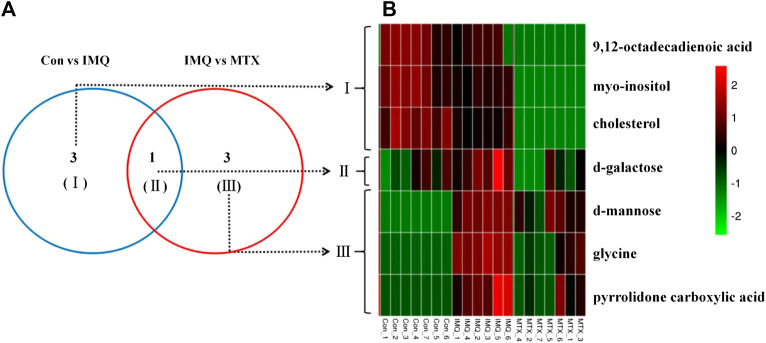
Potential metabolite changes in IMQ-induced psoriasis treated by MTX. Peak area of key metabolites (A) 9,12-octadecadienoic acid, (B) myo-inositol, (C) cholesterol, (D) d-mannose, (E) glycine, (F) pyrrolidone carboxylic acid, and (G) d-galactose. **p < 0.01, *p < 0.01, and p < 0.05 was considered statistically significant.